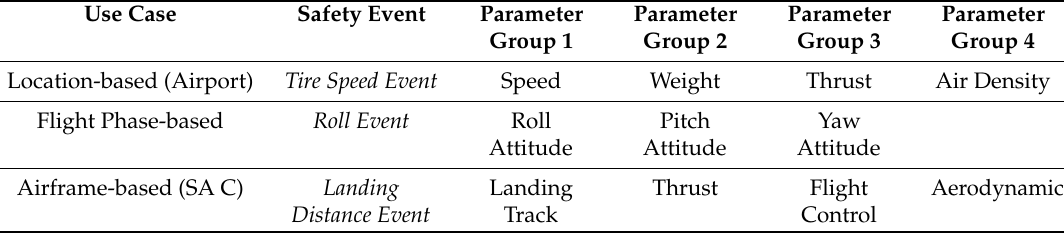
Table 12. Summary of critical parameter groups identified for each use case through the application of SAFE framework . Use Case Safety Event Parameter